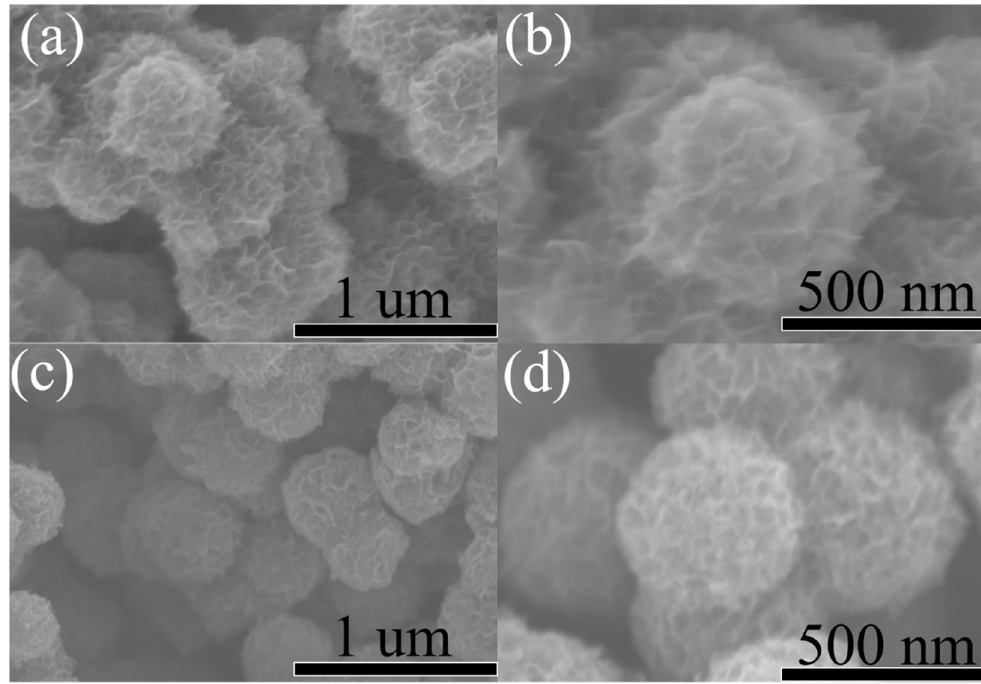
Figure 3. SEM images of ( a , b )1T-MoS 2 -200 and ( c , d ) 1T-MoS 2 -600.